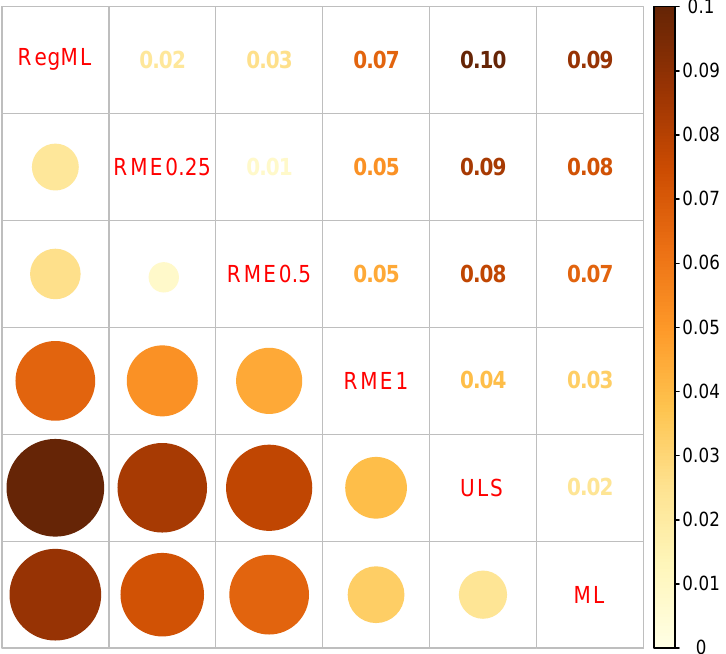
Figure 2. Empirical example: Visualization of average absolute deviations in country means between different estimation methods. Note. ML = maximum likelihood estimate; RegML = regularized maximum likelihood estimate using the Bayesian information criterion for regularization param- eter selection; RME = robust moment estimation with power p in the loss function ρ ( x ) = | x | p ; ULS = unweighted least squares estimate.